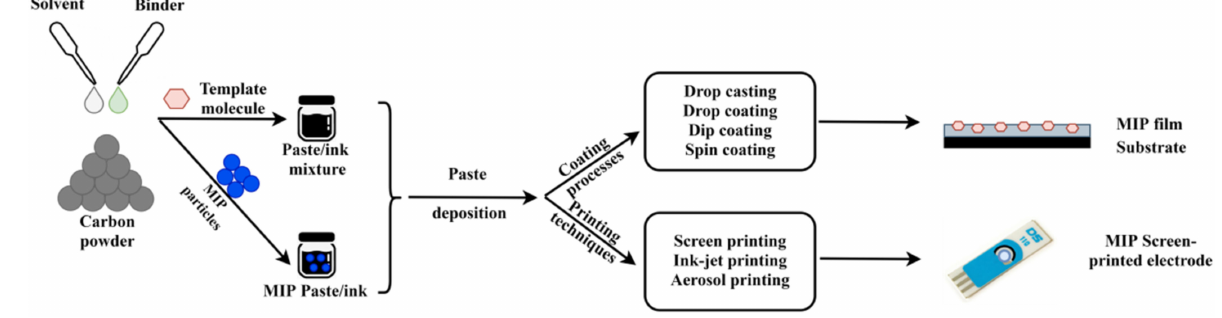
Figure 5. Routes for preparing MIP layers using inks or